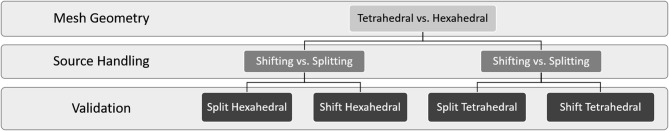
This flow diagram provides an overview of the analysis performed in this manuscript. To establish best practices for interfacing volume conduction models with large-scale NEURON network models, we explored the impact of mesh geometry and current source handling algorithms on computational performance and estimation accuracy. Validation consists of comparison of numerical model estimates with a proxy ground truth in the form of analytical estimates (line-source equation).